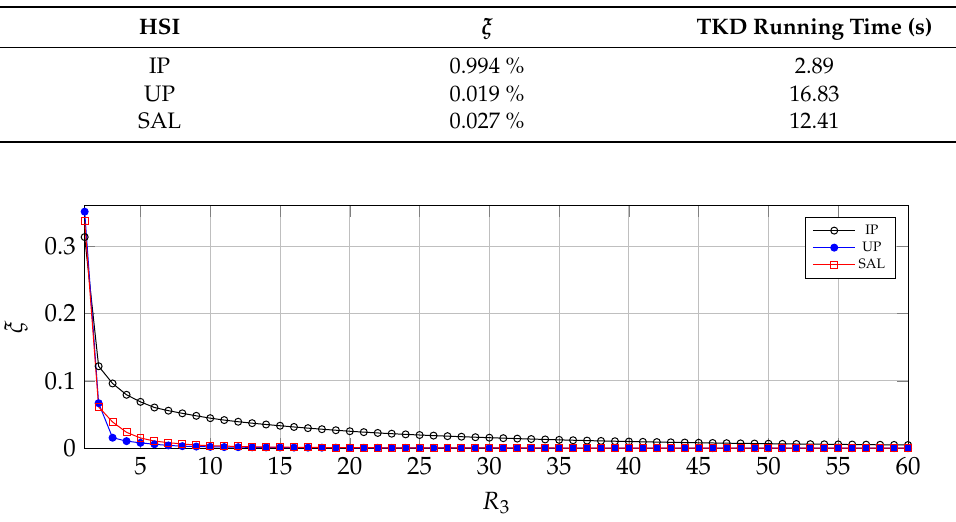
Table 7. Reconstruction error and running time of TKD compressing to 40 tensorial bands.